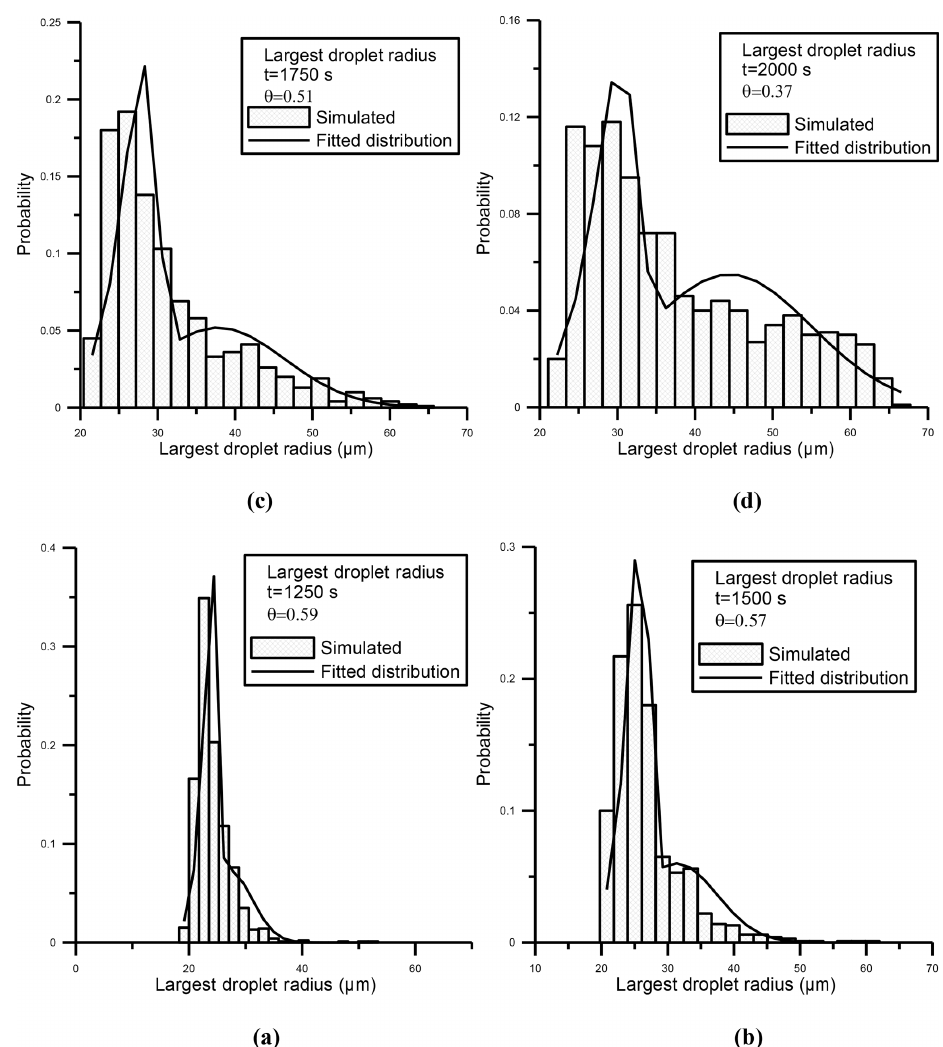
Figure 5. Panels (a) – (d) (histograms) show the simulated M max distributions in a system with an initial bi-disperse distribution (200 droplets of 10µm in radius and 50 droplets of 12.6µm) at four different times. The solid line shows the fit using Eq. (6). The simulations were performed for the turbulent hydrodynamic